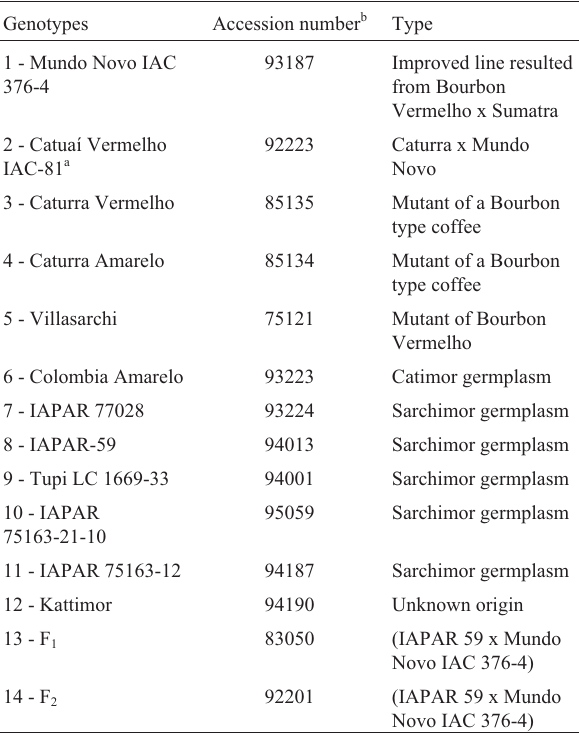
Table 1 - Genotypes, accession numbers and origin types of 14 arabica coffee